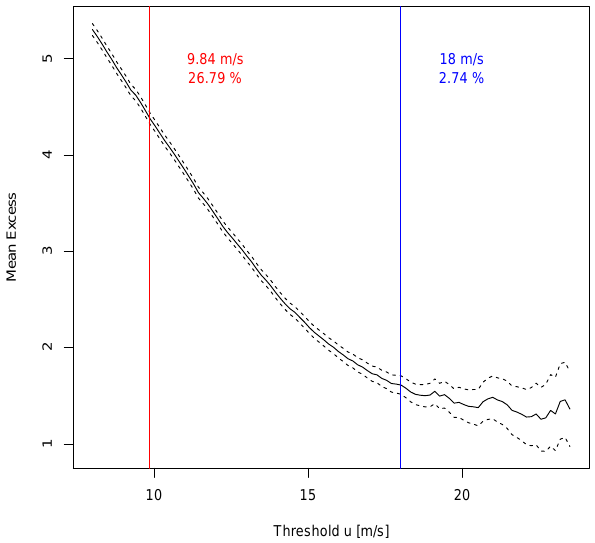
Figure 7. Mean residual life plot for the effective wind component of all three 20C runs. The mean excess (continuous line) and the 95% confidence intervals (dashed lines) are shown. Thresholds de- rived from historical storm surge events (red) and derived from the extreme value statistics (blue) are indicated as vertical lines. In ad- dition, the percentage of these exceedings are specified.